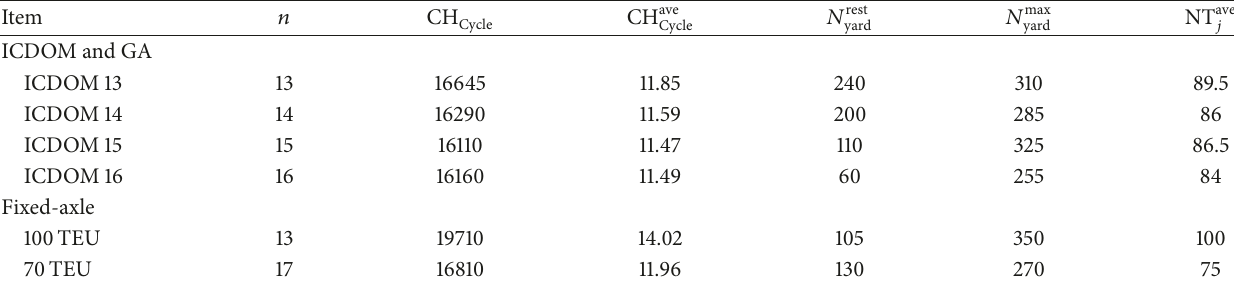
Table 2: Evaluation results of container trains produced by the ICDOM and GA.